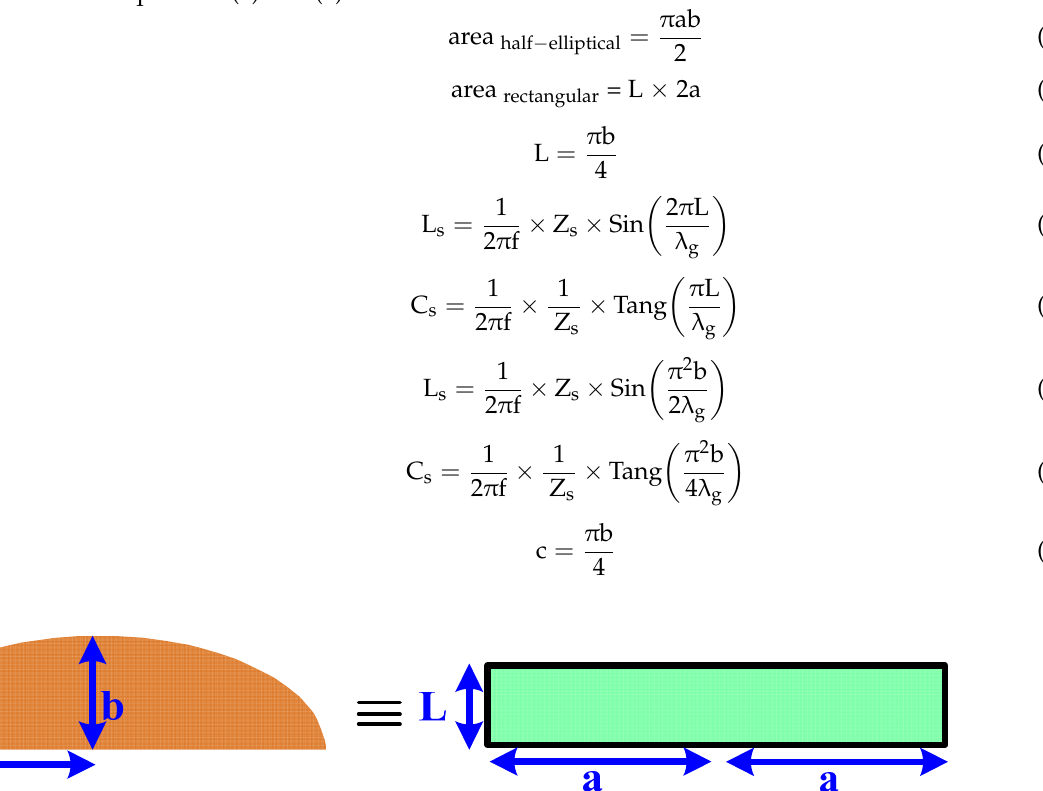
The half-elliptical shaped resonator and the rectangular resonator are shown in Figure 4. A new length “L” is calculated in Equation (3) and used to calculate the LCE circuit of the half-elliptical resonator. The “a” and “b” are the diameters of the half-elliptical shape. The semi-elliptical area is calculated in Equation (1), and the area of the rectangular shape is calculated in Equation (2). The new “L” is calculated in Equation (3) and used in Equations (4) and (5). The LC equivalent circuit of the semi-circular resonator is calculated in Equations (6) and (7).